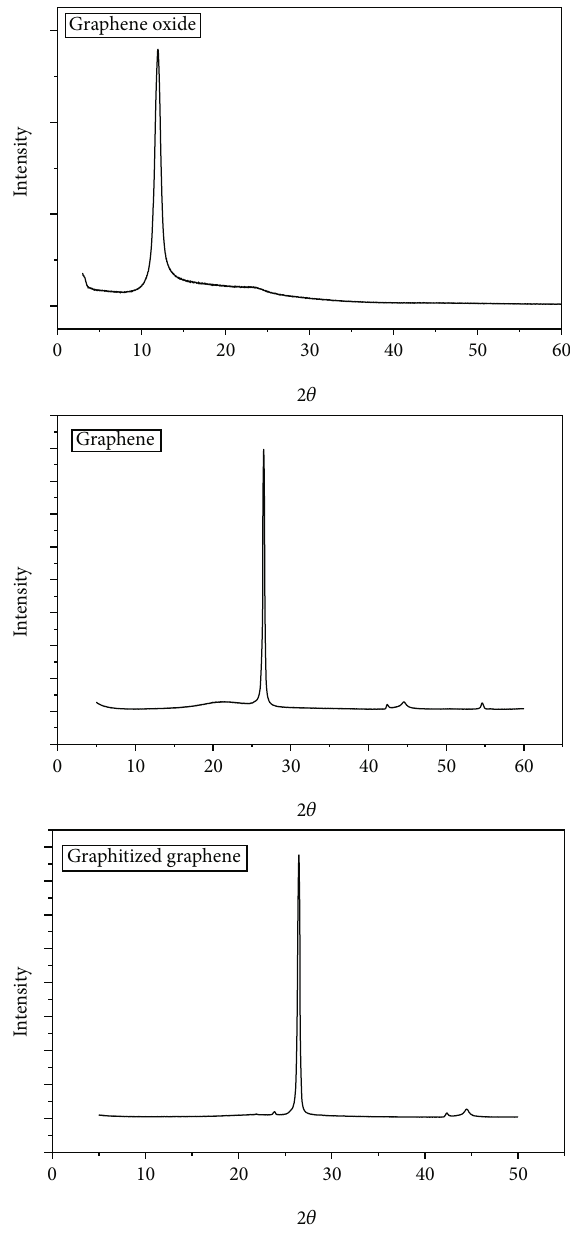
Figure 3: XRD structure of graphene oxide, graphene, and graphitized